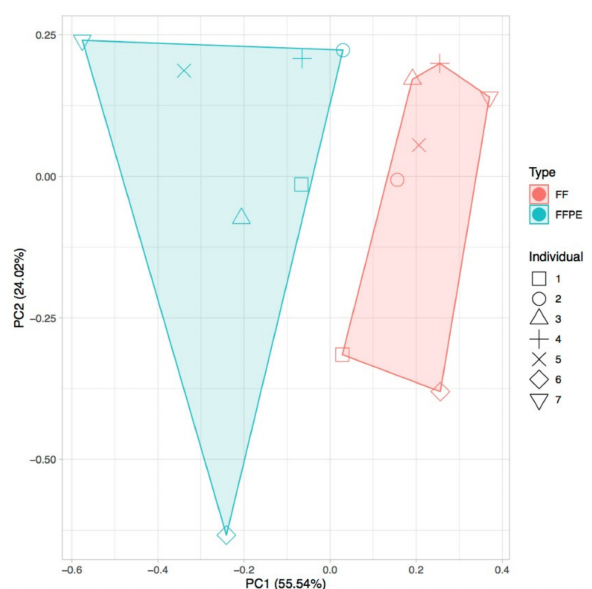
Figure 2. Principal component analysis (PCA) for fresh frozen (FF) and formalin-fixed, para ffi n-embedded (FFPE) matched samples from seven individuals, using transcripts-per-million (TPM) values of gene expression (average for all replicates) and discarding genes with TPM < 1.